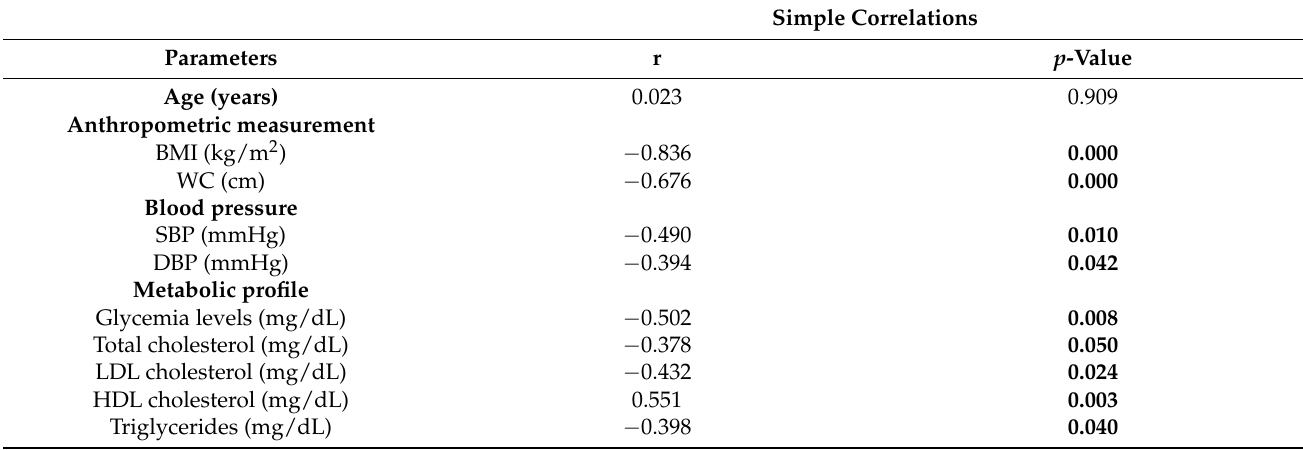
Table 5. Correlations of chronotype score with study parameters adjusted for sex in patients with craniopharyngioma.